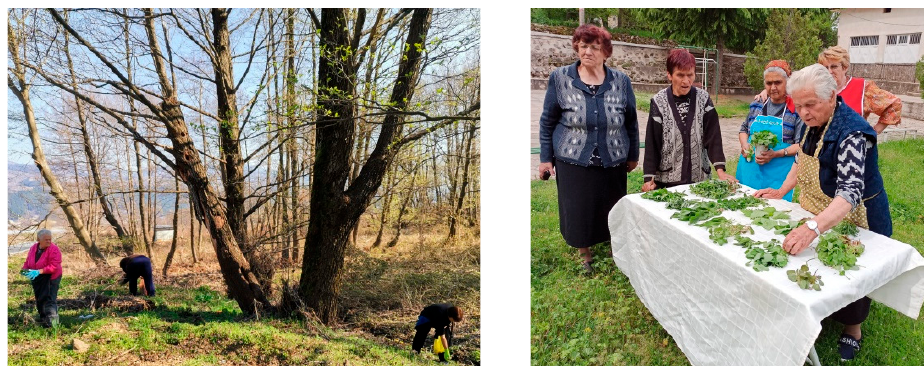
Figure 3. Gathering of spring wild vegetables alongside village road in SW Bulgaria (Gabrene village, Blagoevgrad Province).